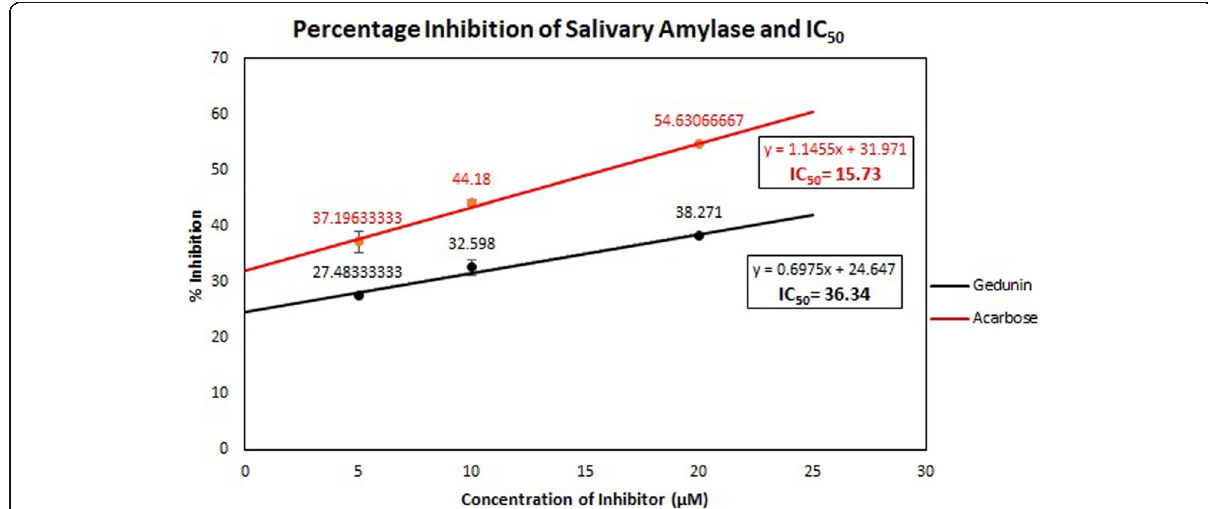
Fig. 7 Percentage inhibition of salivary alpha amylase at different concentrations of gedunin and acarbose (standard drug) and IC 50 . Values represents mean ± SD for three independent experiments and error bars represent standard error